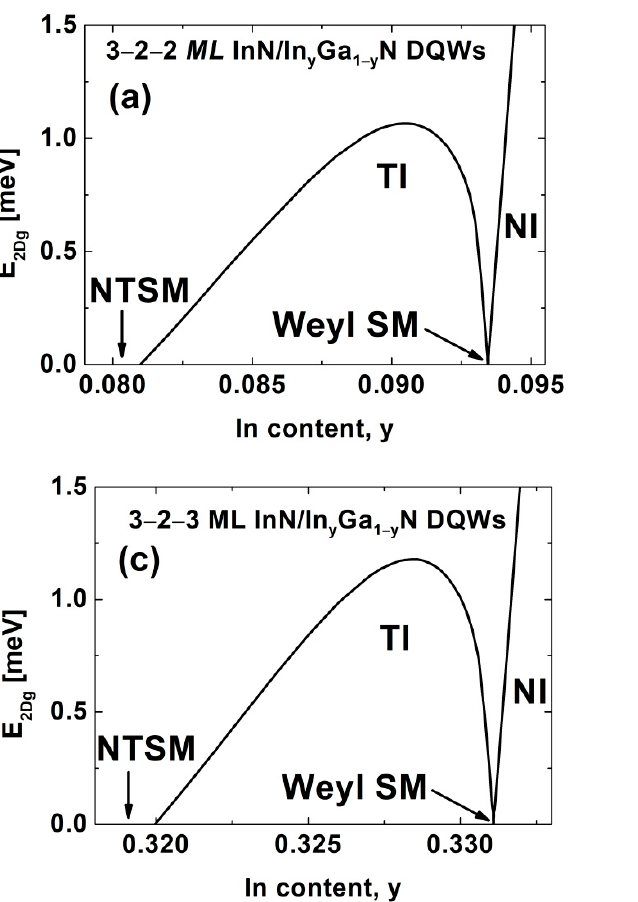
8 of 13 Figure 3. The 𝐸 (cid:2870)(cid:3005)(cid:3034) as a function of the In content in the QWs, for In x Ga 1 − x N/GaN DQWs with ( a ) 𝐿 (cid:3044)(cid:3050),(cid:3002) = 2 𝑀𝐿𝑠 , 𝐿 (cid:3044)(cid:3050),(cid:3003) = 3 𝑀𝐿𝑠 , and 𝐿 (cid:3036)(cid:3029) = 2 𝑀𝐿𝑠 ; and ( b ) 𝐿 (cid:3044)(cid:3050),(cid:3002) = 3 𝑀𝐿𝑠 , 𝐿 (cid:3044)(cid:3050),(cid:3003) = 3 𝑀𝐿𝑠 , and 𝐿 (cid:3036)(cid:3029) = 2 𝑀𝐿𝑠 . 3.2. InN/In y Ga 1 − y N DQWs We extended our investigations to InN/In y Ga 1 − y N DQWs. We assumed that these structures are pseudomorphically grown on metamorphic In y Ga 1-y N buffer layers or In y Ga 1 − y N virtual substrates, which are used in optoelectronic devices [42–45]. In Figure 4, we present the 𝐸 (cid:2870)(cid:3005)(cid:3034) for InN/In y Ga 1-y N DQWs with (a) 𝐿 (cid:3044)(cid:3050),(cid:3002) = 3 𝑀𝐿𝑠 and 𝐿 (cid:3044)(cid:3050),(cid:3003) = 2 𝑀𝐿𝑠 , (b) 𝐿 (cid:3044)(cid:3050),(cid:3002) = 2 𝑀𝐿𝑠 and 𝐿 (cid:3044)(cid:3050),(cid:3003) = 3 𝑀𝐿𝑠 , and (c) 𝐿 (cid:3044)(cid:3050),(cid:3002) = 3 𝑀𝐿𝑠 and 𝐿 (cid:3044)(cid:3050),(cid:3003) = 3 𝑀𝐿𝑠 . The width of the interwell barrier is 𝐿 (cid:3036)(cid:3029) = 2 𝑀𝐿𝑠 . In all cases, we see the TPT from the NI to the TI via the WSM and the NTPT from the TI to the NTSM. These phase transitions are driven by an increase in the built-in electric field in QWs, due to a decrease in the In content in the barriers, y. For the structures presented in Figure 4a–c, the TPT occurs at a y equal to 0.09345, 0.10937, and 0.3311, respectively. Therefore, the values of (cid:3627)𝜀 (cid:3051)(cid:3051),(cid:3044)(cid:3050)(cid:3021)(cid:3017)(cid:3021) (cid:3627) are